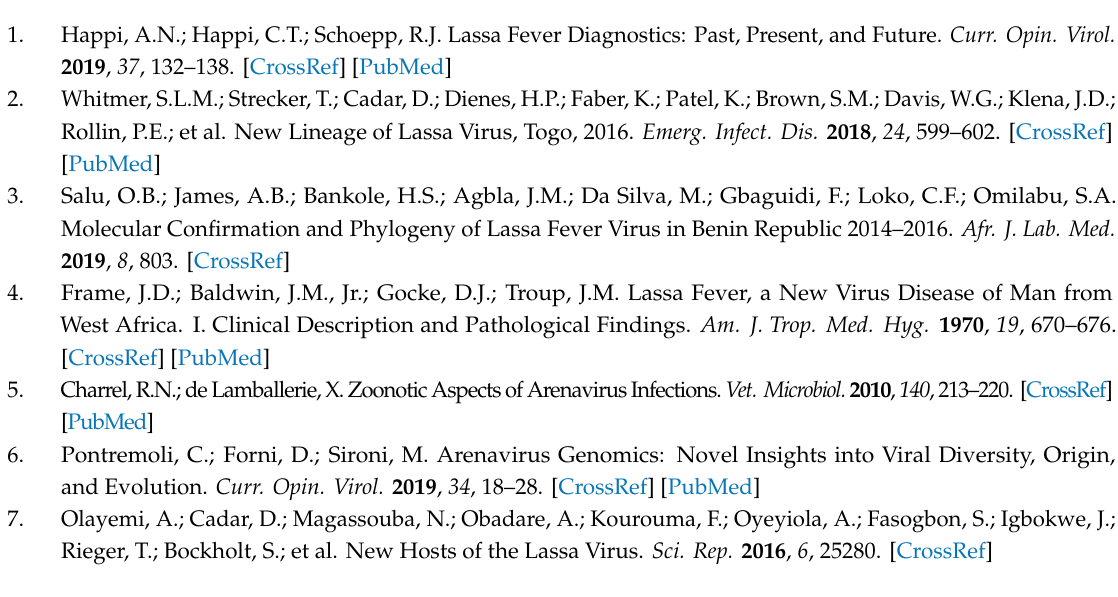
Table S1. list of 280 strains used for STRUCTURE analysis and DAPC; Table S2. list of lineage IIg strains with outcome information; Table S3. recombination events; Figure S1. Population structure of LASV in West Africa: analysis of optimal K; Figure S2. DAPC cluster selection; Figure S3. Population structure of lineage IIg: analysis of optimal K; Figure S4. Plasma viral loads in clade IIg strains; Figure S5. Variant distribution of IIg-1